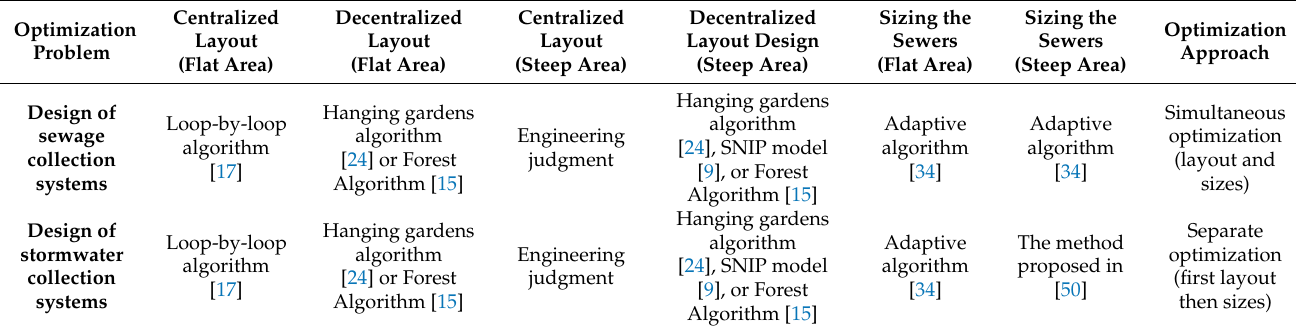
Table 6. The suggested methods for different UDS design optimization